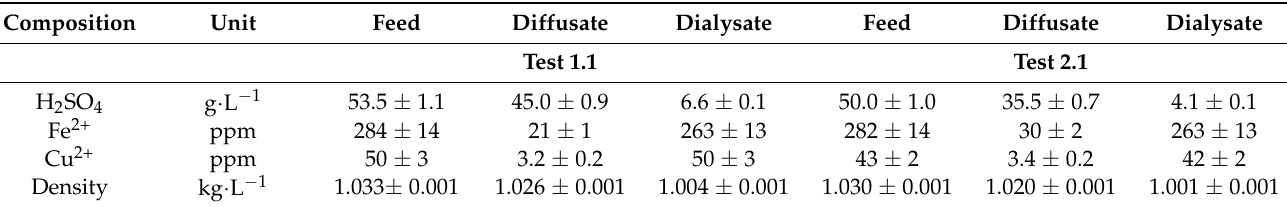
Table 3. Analytical measurements for Tests 1.1 and